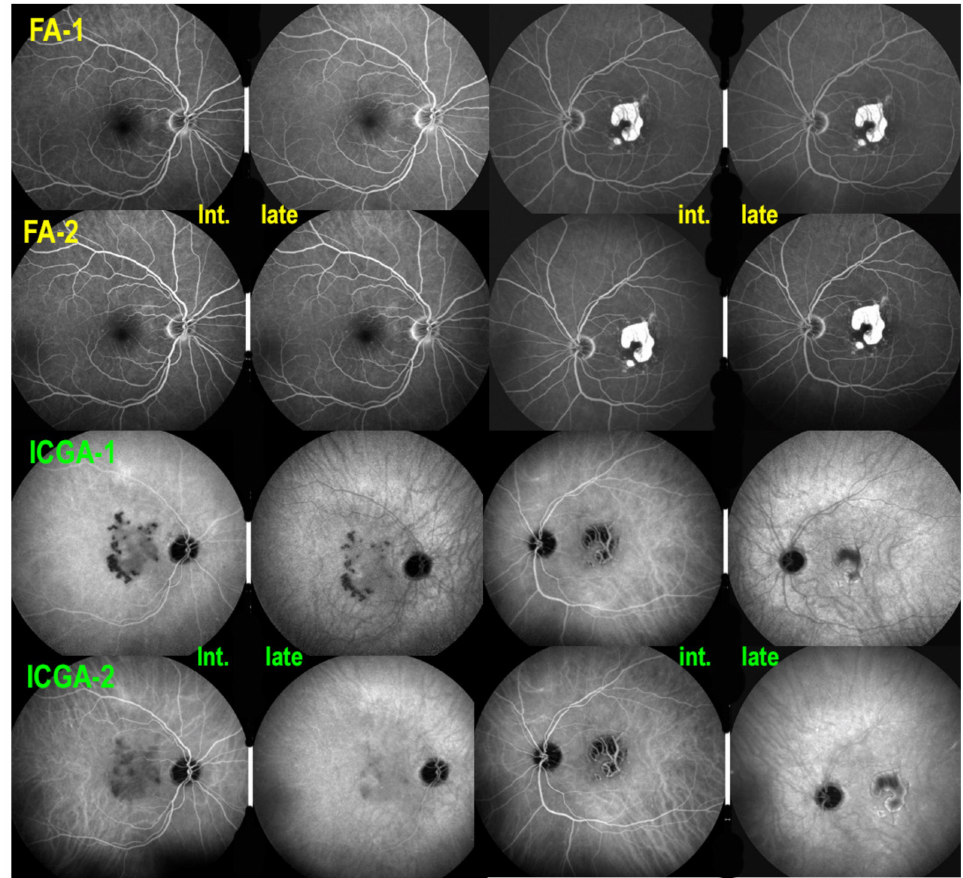
Figure 17. Serpiginous choroiditis. Recurrence of ICGA hypofluorescence 9 months after first presentation despite sub-Tenon’s injections of triamcinolone acetonide (40 mg). Initiation of triple immunosuppression (IS) is decided. FA-1 ODS before introduction of IS (top 4 frames) did not show occult increase of non-perfusion detected in both eyes by ICGA hypofluorescence (ICGA-1). After the introduction of IS, there was no change on FA (FA-2), while there was a marked reduction of hypofluorescence on ICGA (ICGA-2) especially on late frames, except for the irreversible chorioretinal atrophy